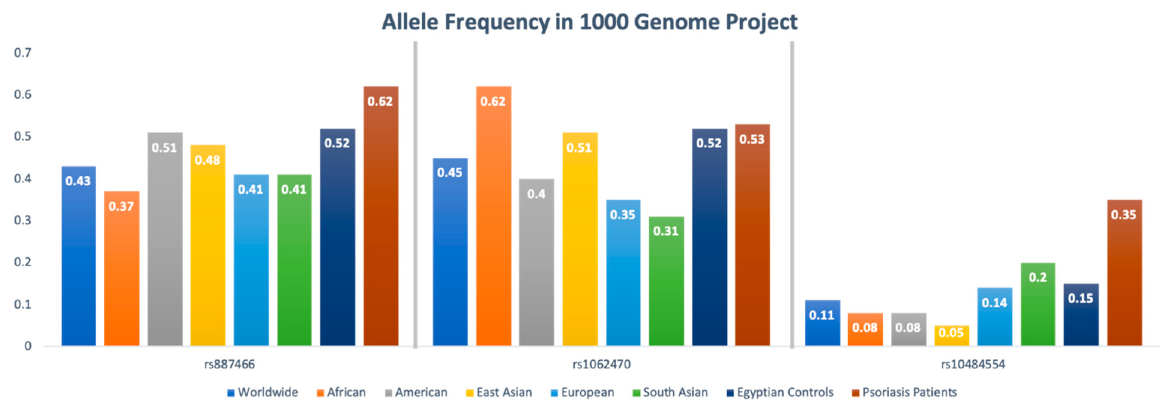
Figure 3. Allele frequencies of PSORS1C3 gene rs887466, rs1062470 and rs10484554 in 1000Genome